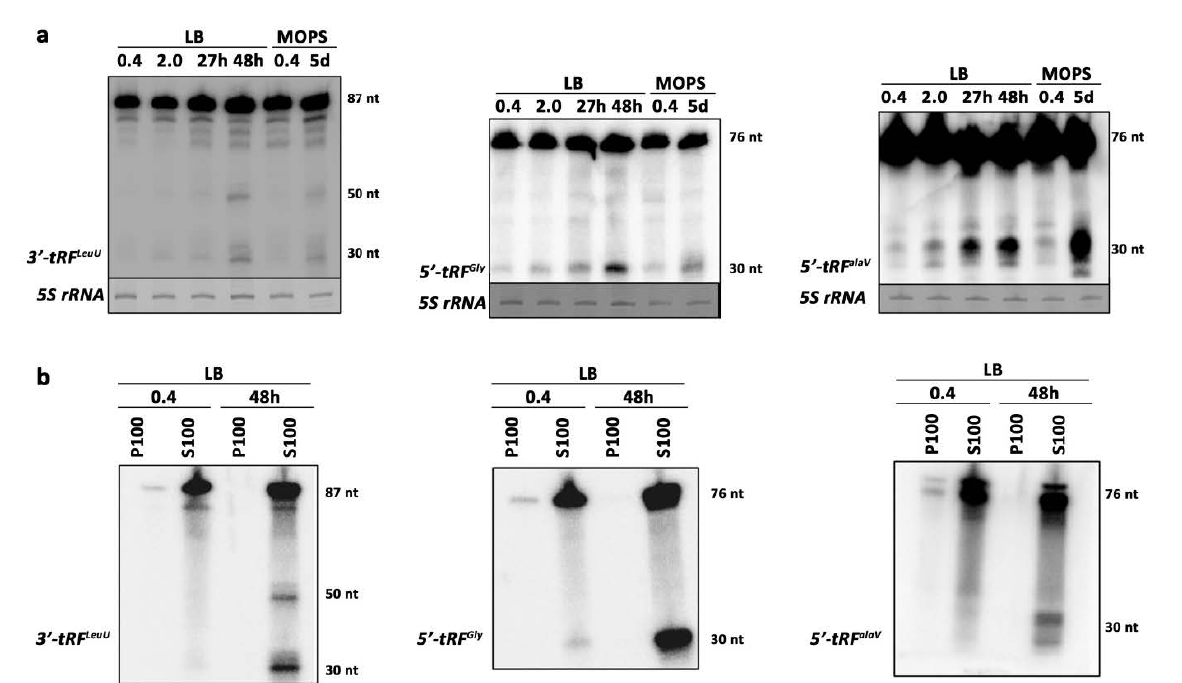
Figure 4. Stationary phase-specific transfer RNA fragments. ( a ) Northern blot analysis probing for 3 (cid:48) -tRF LeuU (FM_- NC_000913.2_3320093_38), 5 (cid:48) -tRF Gly (FM_+NC_000913.2_4390382_32), and 5 (cid:48) -tRF AlaV (FM_+NC_000913.2_0225499_28). 5S rRNA was used as a loading control. Zero point four and 2 were optical density measurements, h: hours, d: days. tRF = tRNA derived RNA fragment. ( b ) Northern blot analysis probing for 3 (cid:48) -tRF LeuU , 5 (cid:48) -tRF Gly , and 5 (cid:48) -tRF AlaV . P100 = pellet enriched for ribosome-associated RNA. S100 = supernatant containing non-ribosome associated